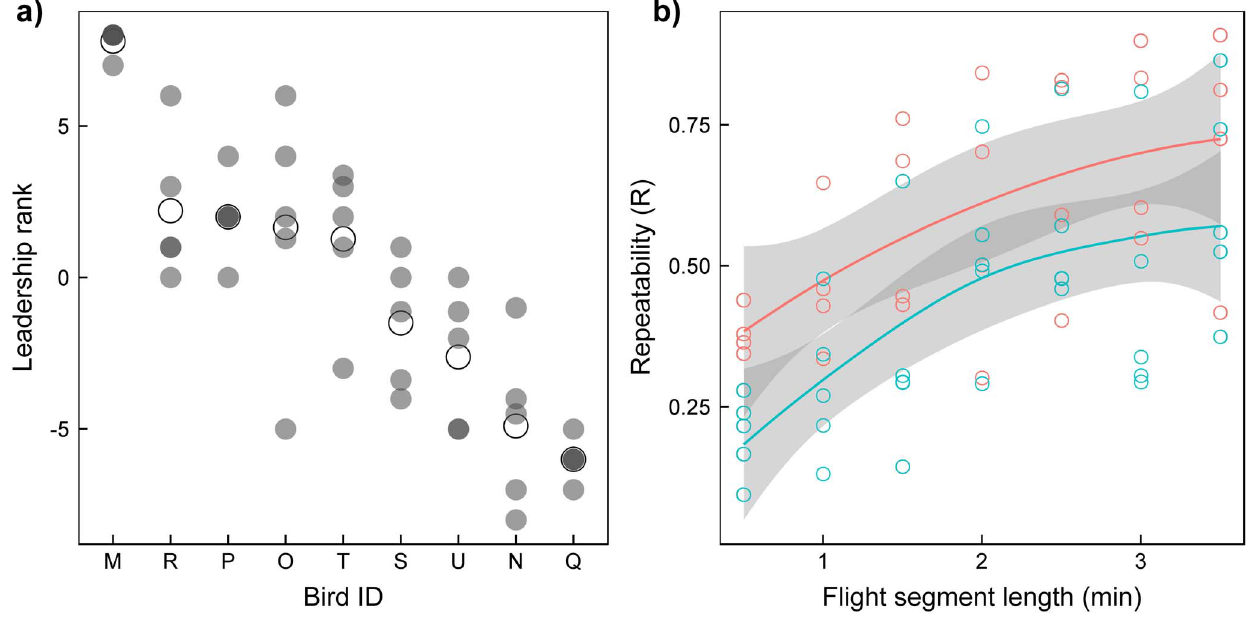
Figure 1. Within-flight leadership consistency. (a) Individual leadership ranks calculated for multiple segments (2.5 min long) of the same flight (illustrated for flight number 8). Average ranks are represented with open dots. The repeatability of leadership pairwise scores (R), P-value and confidence intervals are shown in Table 1. (b) Repeatability of leadership pairwise scores as a function of flight segment length (blue for pigeons with balanced homing experience and red for pigeons with unbalanced homing experience). Dots represent repeatability of different flights when flight segments of different lengths are considered. Trend lines are LOESS curves with 95% confidence intervals.